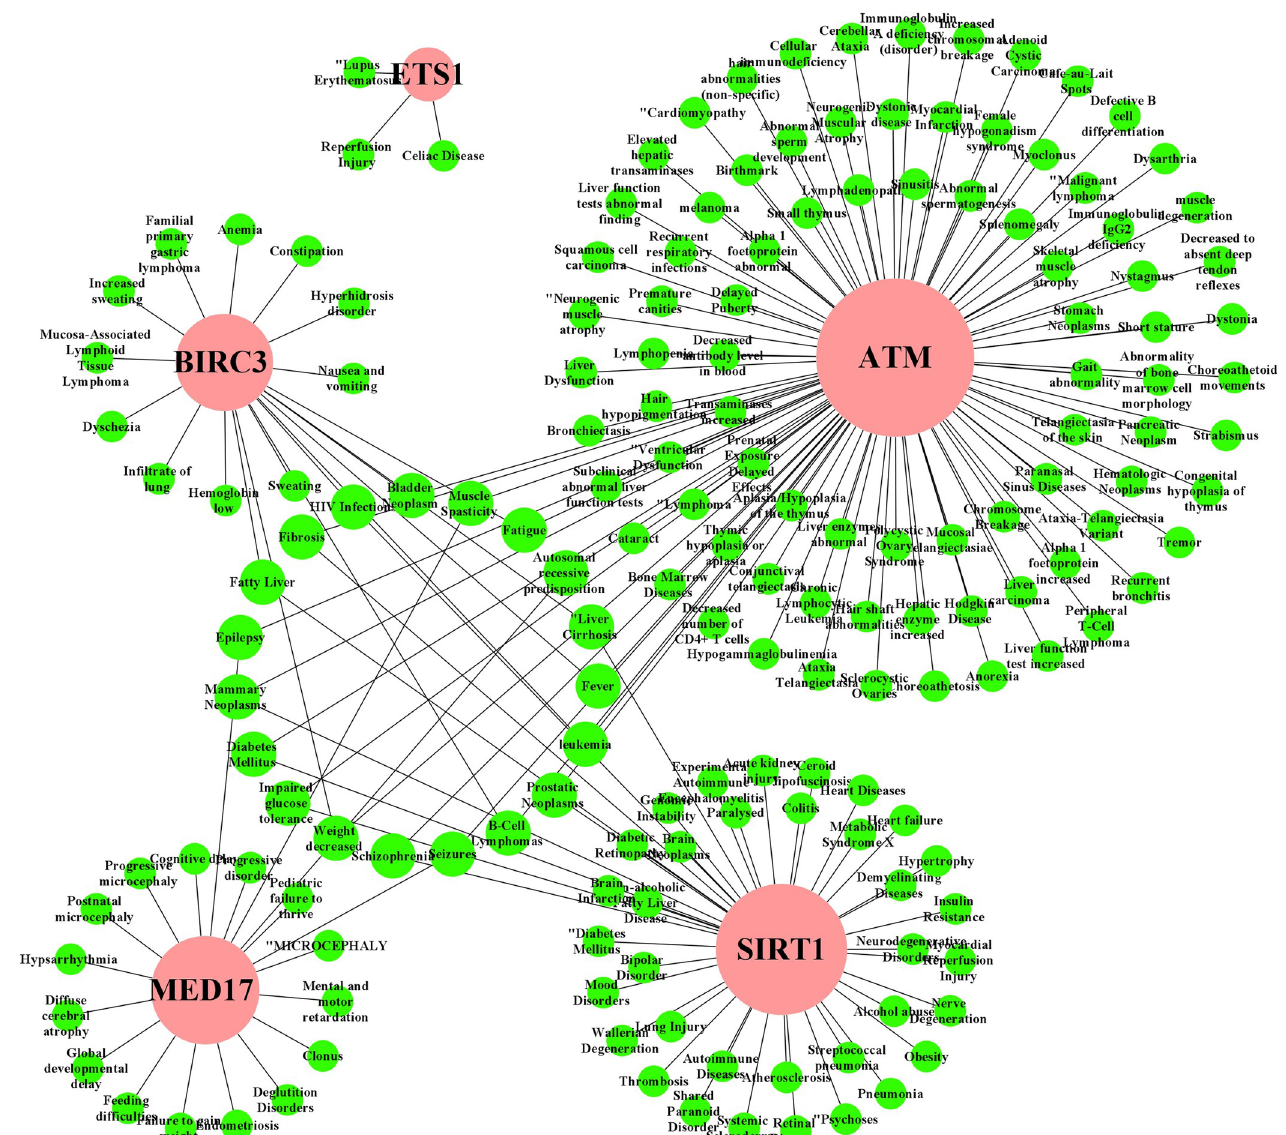
Fig 5. Identification of comorbidities that may be influenced genetically by the SARS-CoV-1 infections. The HubGs versus disease interaction network, where circle-shape with pink color indicates HubGs and circle-shape with other color indicates different diseases/comorbidities.